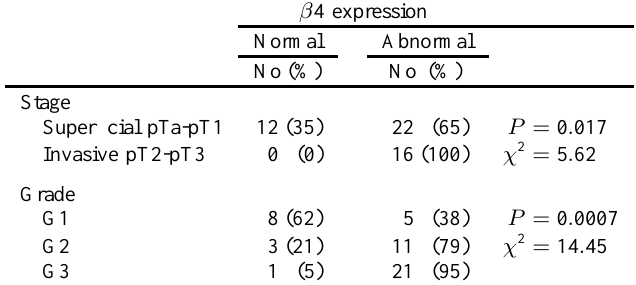
Table 2 Relationships of (cid:12) 4 integrin expression to histopathological